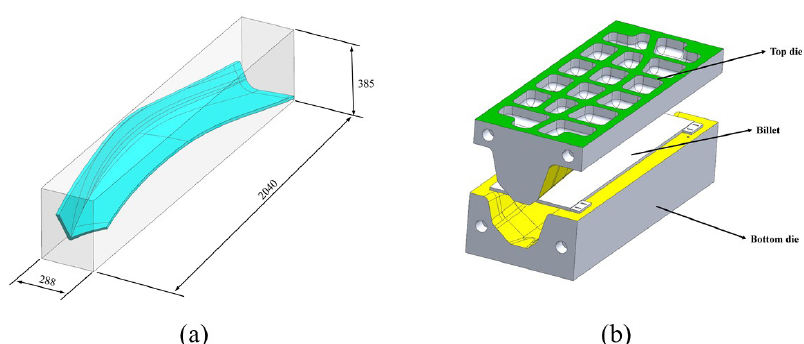
Figure 12. 3D model of (a) the V-shaped part and (b) the forming die.